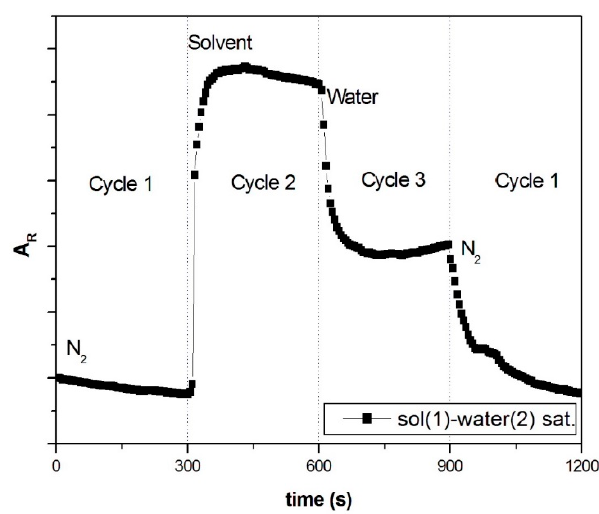
Figure 4. General evolution of relative amplitude (A R ) when submitted to N 2 -VOC-H 2 O saturated vapors sequences.